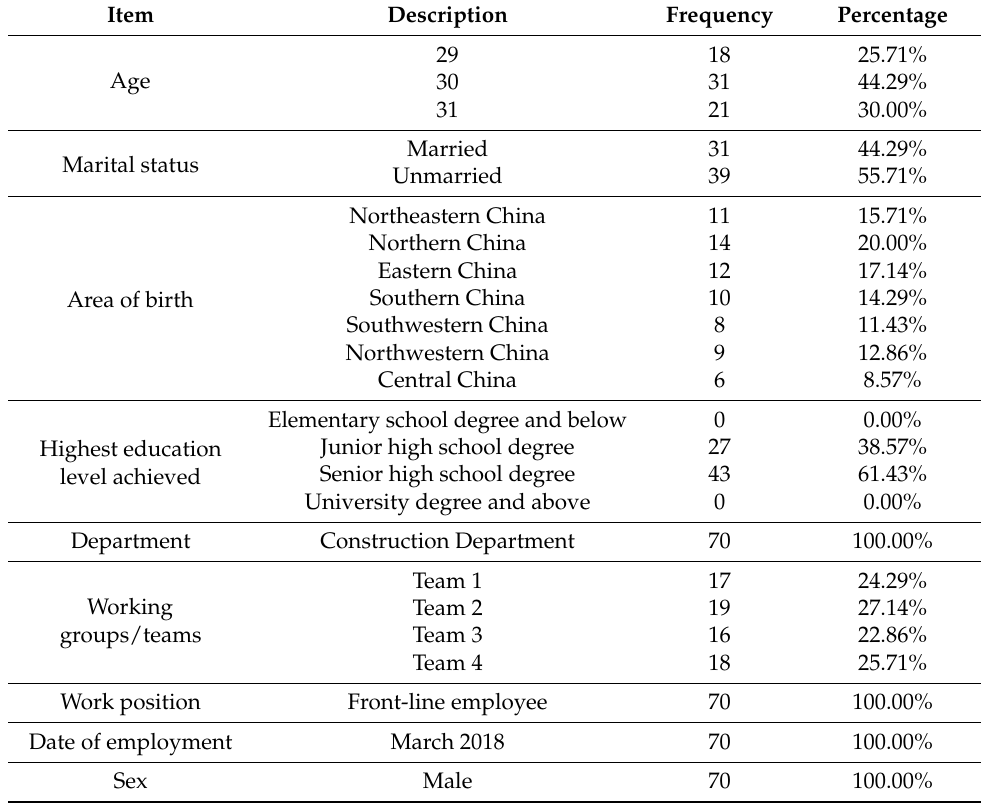
Table 1. Descriptive statistics of samples.